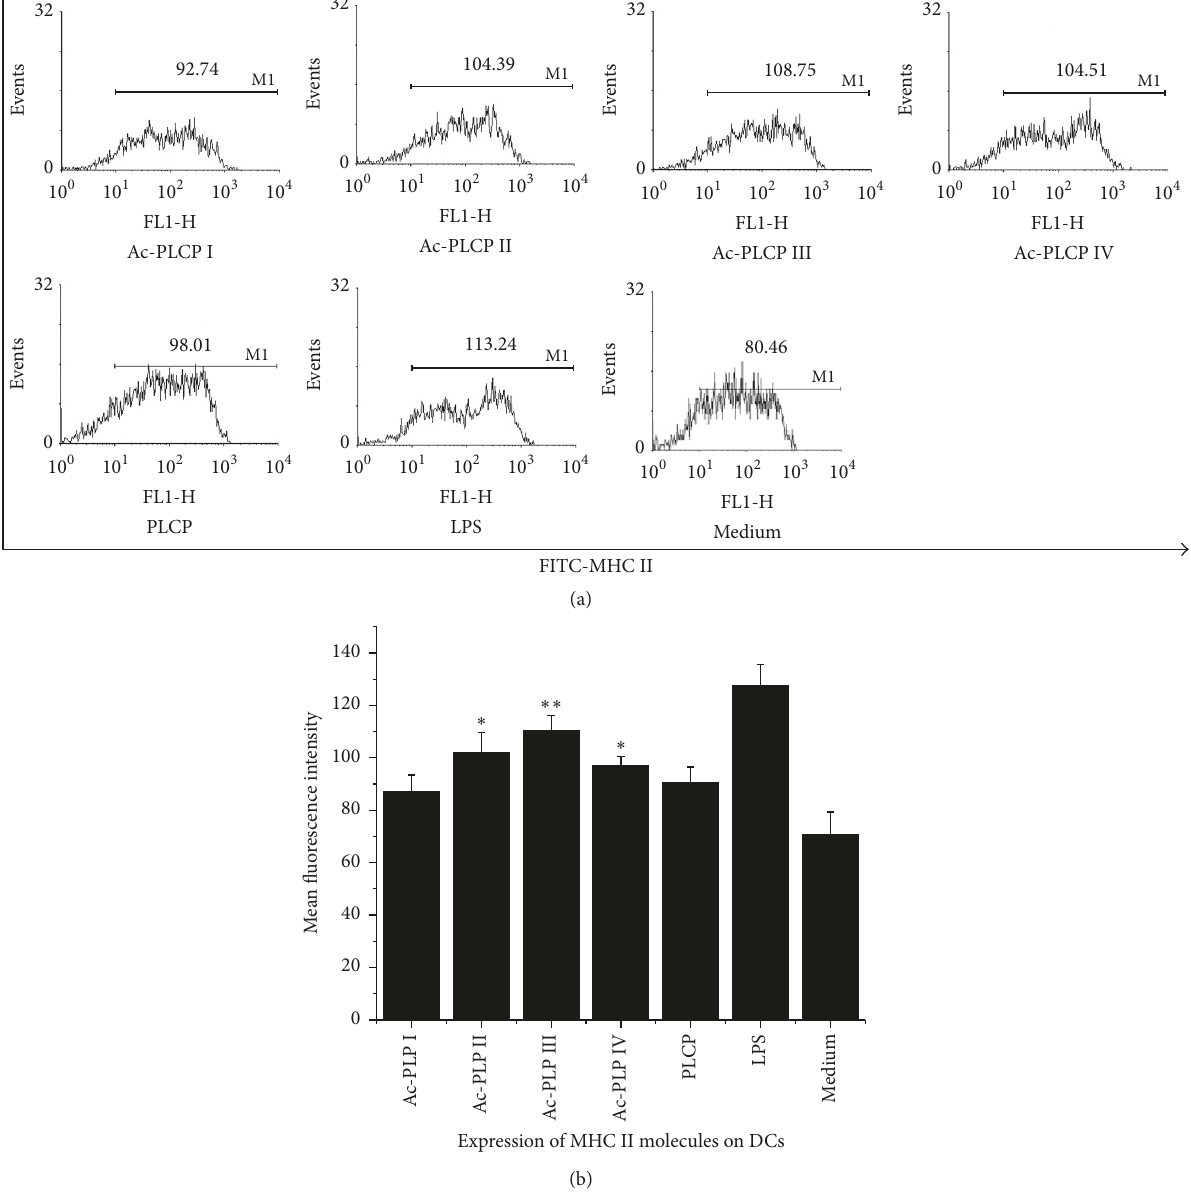
Figure 1: Ac-PLCP increased the expression of MHC II molecules on DCs. Immature DCs were treated with 100 𝜇 g/mL PLCP or Ac-PLCPs for 48 h. Then, the expression levels of MHC II molecules were determined by flow cytometry. The data were shown as mean fluorescence intensity (MFI). Compared with medium group, DCs treated with PLCP expressed higher level of MHC II molecules. While compared with thePLCPgroup,significantincreasesinMFIwereobservedinAc-PLCPII,III,andIVgroups.Theresultsshownwerefromonerepresentative experiment of three independent experiments performed. ∗ 𝑃 < 0.05 compared to the PLCP group; ∗∗ 𝑃 < 0.01 compared to the PLCP